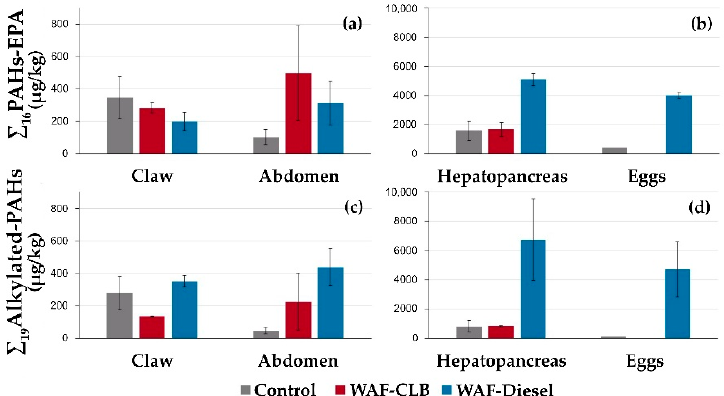
Figure 11. ∑ 16 PAHs-EPA and ∑ 19 Alkylated-PAHs measured in claw and abdomen ( a , c , respectively) and hepatopancreas and eggs ( b , d , respectively) for each treatment. Mean ± SE; n = 2, except for eggs in Control (n = 1) and WAF-CLB (n = 0).